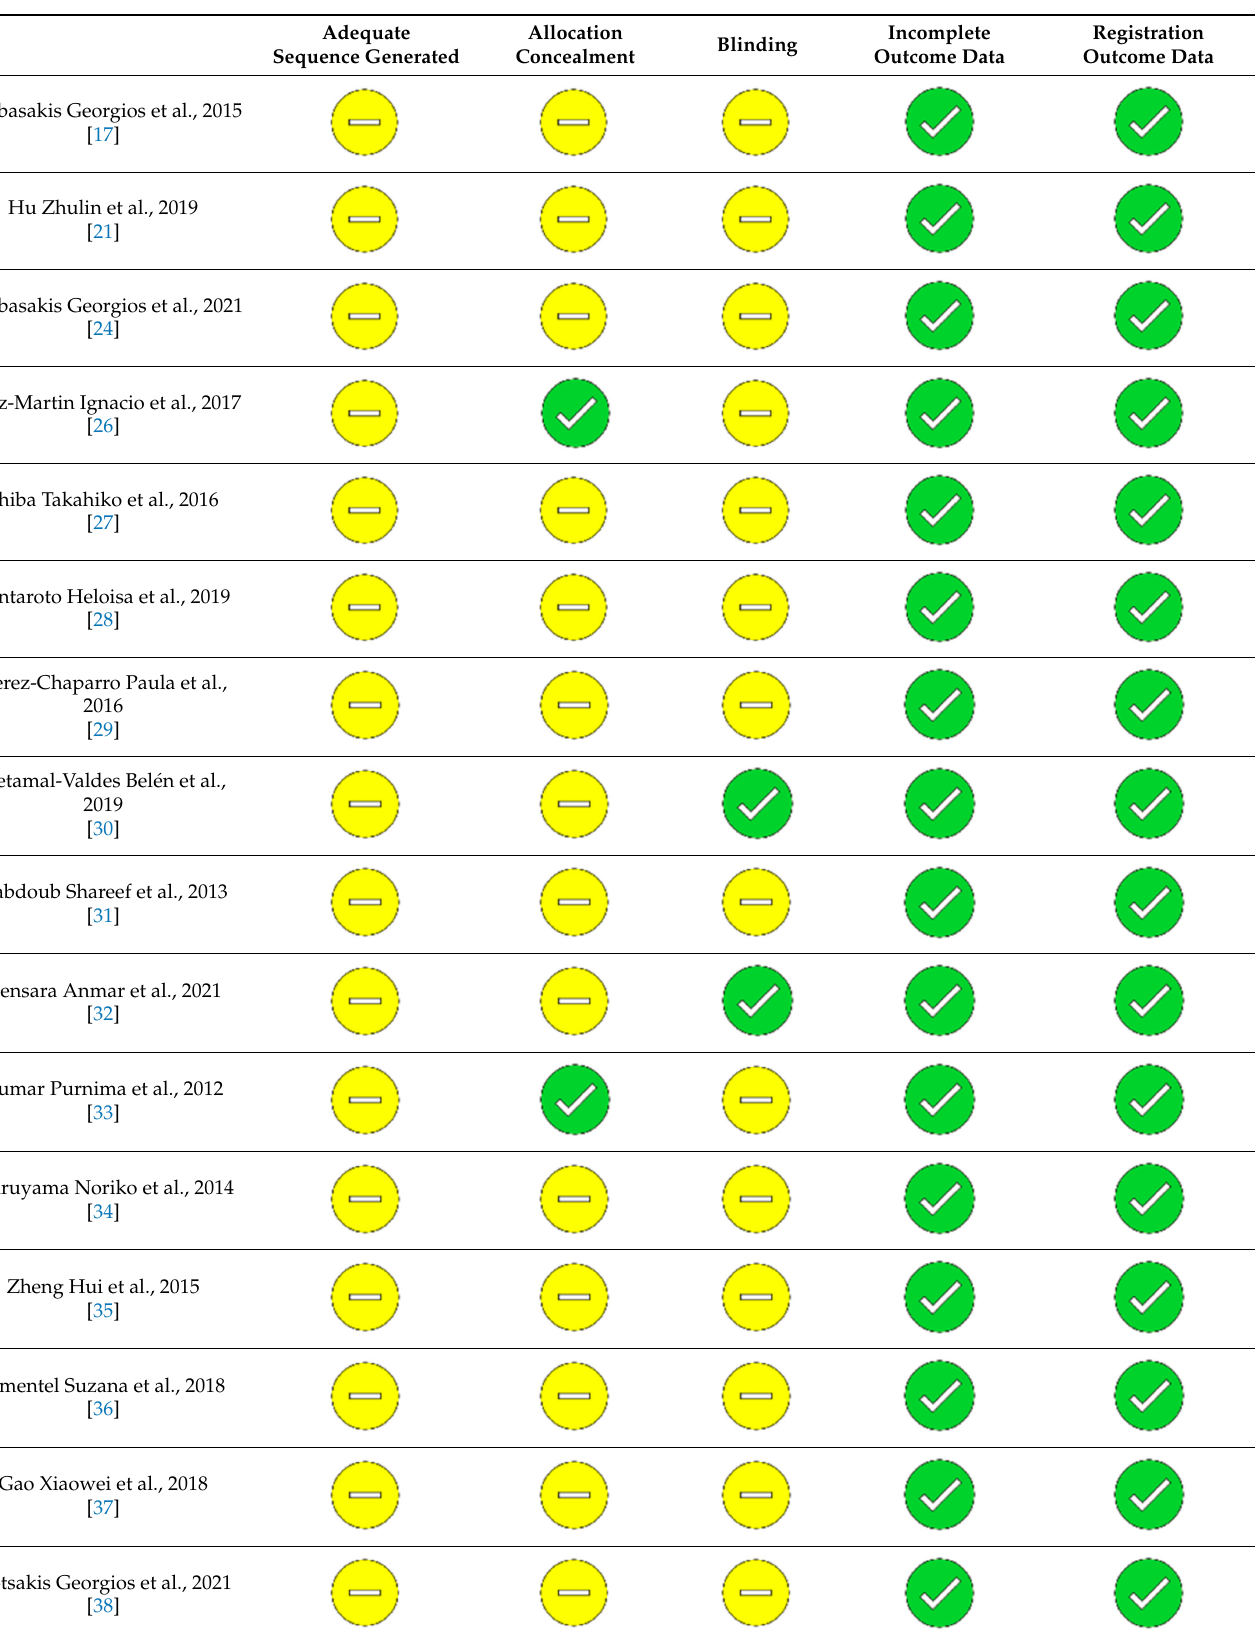
Figure 1. Number of research papers published until 2021.